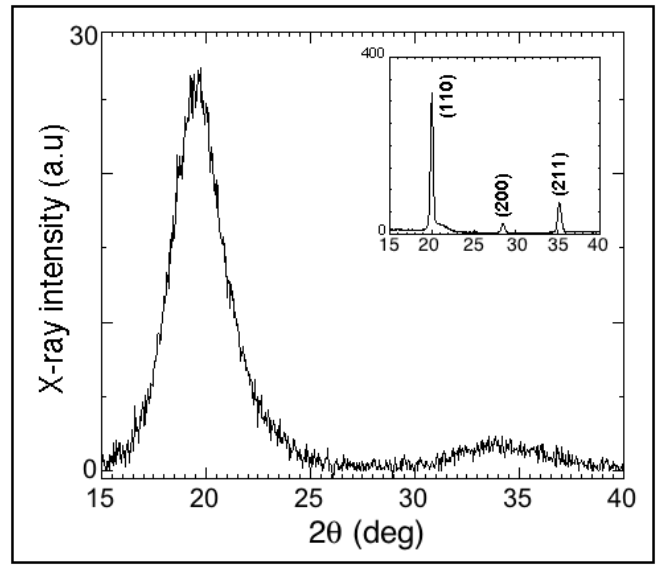
Figure 1. X-ray diffractogram corresponding to as-deposited pulsed laser deposition (PLD) Fe film showing the typical halo of amorphous or nanocrystalline material. Inset shows diffractogram corresponding to crystalline Fe target used for deposition, where crystalline peaks corresponding to (110), (200), and (211) planes were detected.